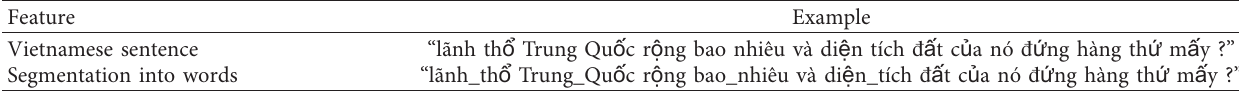
Table 1: A Vietnamese sentence and the result of its segmentation into words.